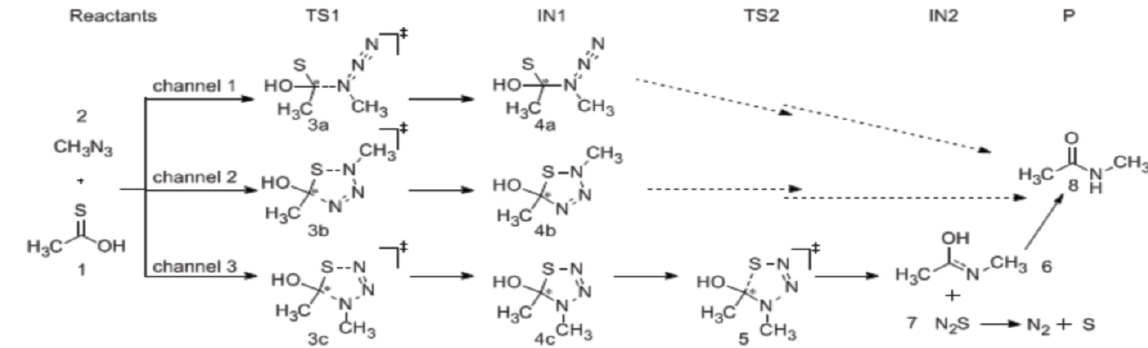
Figure 1. The potential energy profile for reaction I computed with B3LYP/6-31G(d)//B3LYP/6-311++G(d,p) method with ZPE corrected energies ( ∆ E ) relative to the 0